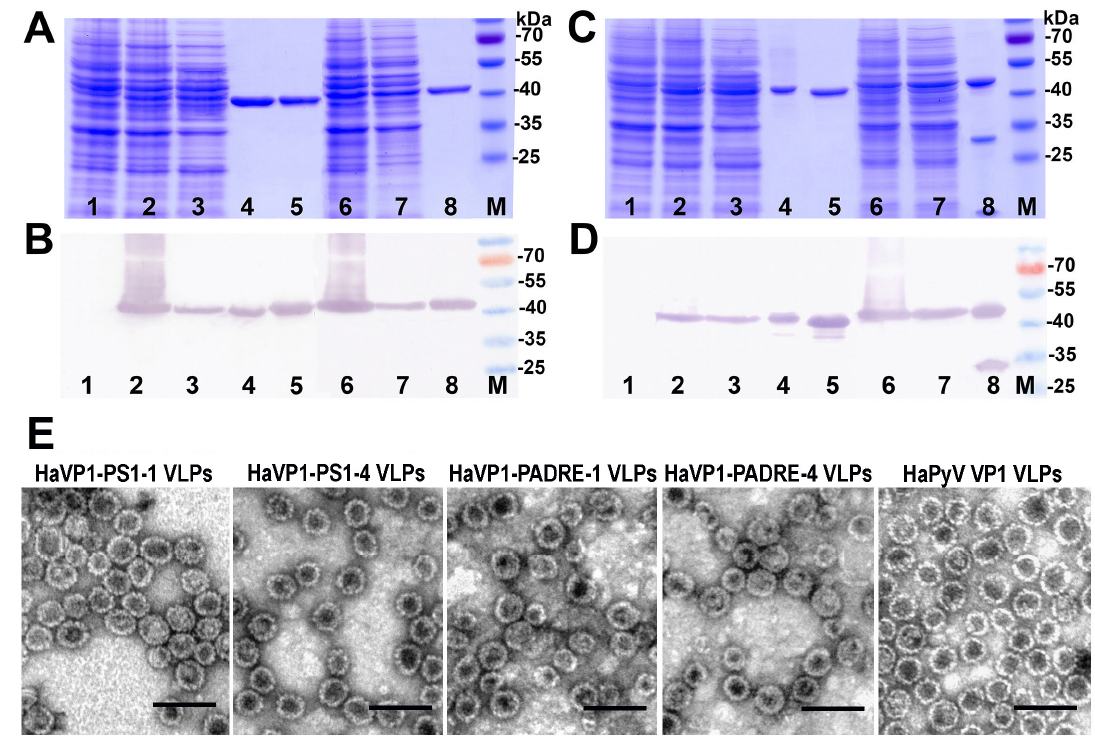
Figure 5. Analysis of the production of chimeric proteins HaVP1-PS1 ( A , B )